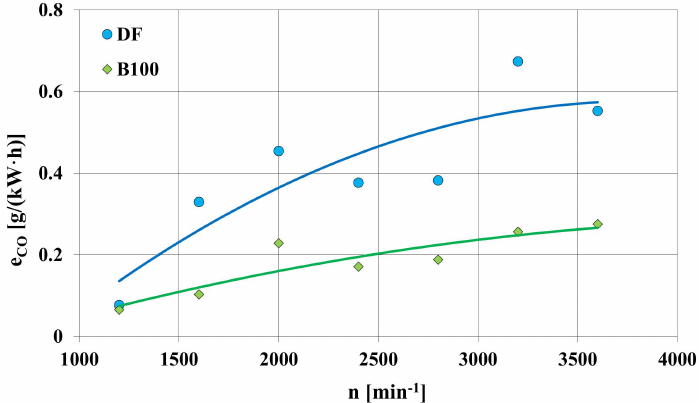
Figure 5. External speed characteristics of the specific brake emission of carbon monoxide-e CO in the rotation speed domain-n for the engine powered with fuels DF diesel or B100.